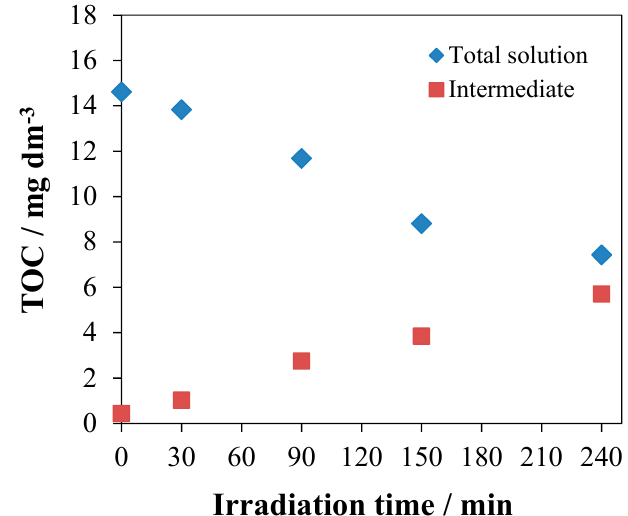
Figure 13. The change of the total organic carbon (TOC) values during the photocatalytic degradation of 1,4-HQ over NT-U catalyst.